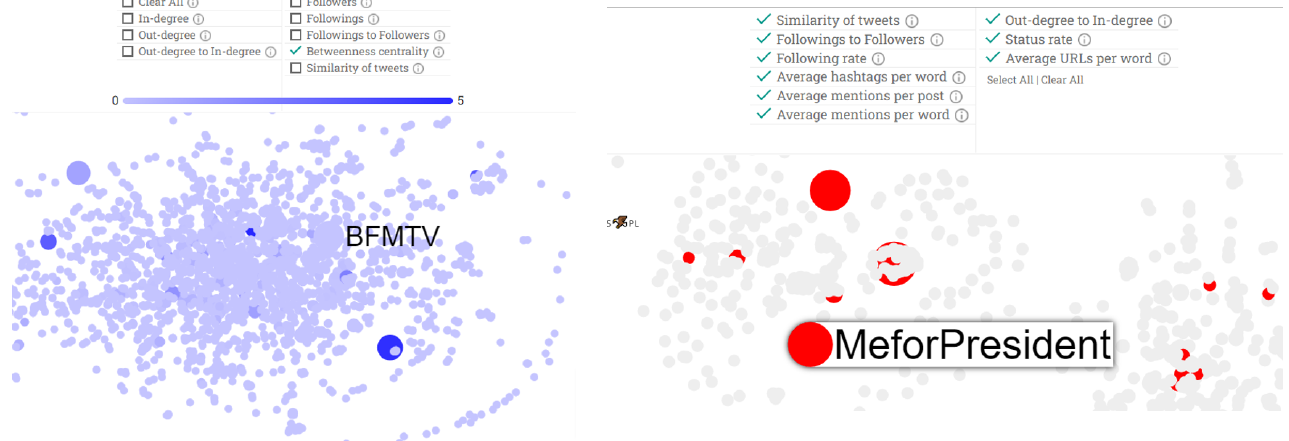
Figure 5. Example of the node-coloring filter ( left ) and highlighting suspicious accounts filter ( right ).